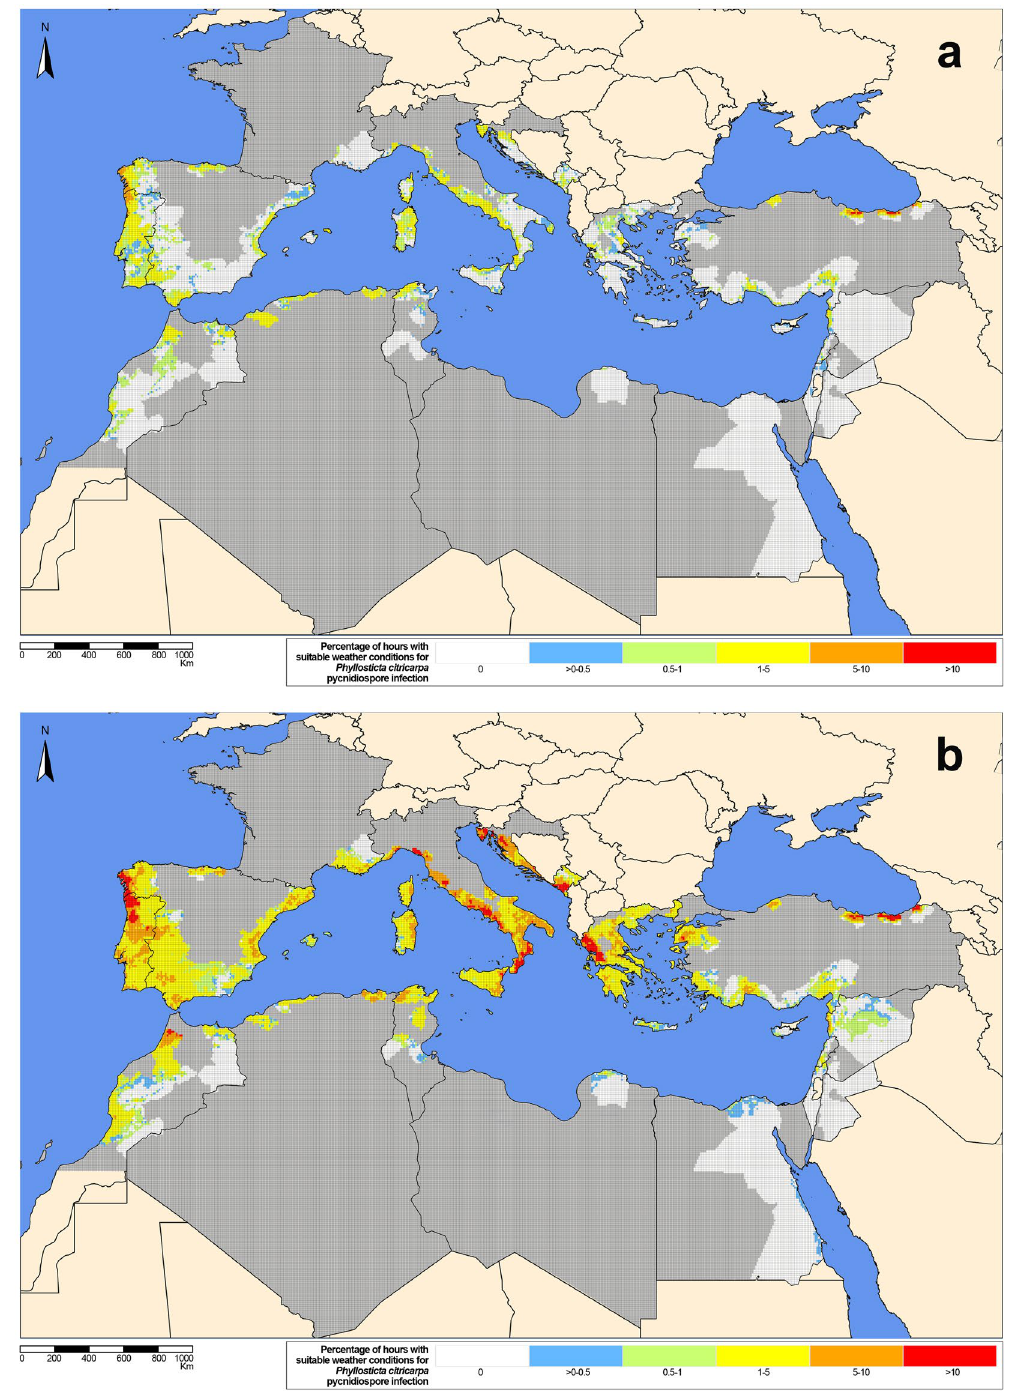
Figure 2. Percentage of hours ( = 0 white, ]0–0.5] blue, ]0.5–1] green, ]1–5] yellow, ]5–10] orange, > 10 red) with suitable weather conditions for Phyllosticta citricarpa pycnidiospore infection (generic infection model for foliar fungal pathogens by Magarey et al. 33 , configuration scenario S1) for the 9-km grid interpolated climatic data of the citrus-growing regions in the Mediterranean Basin from 2009 to 2018 for ( a ) spring (March to May) and ( b ) autumn (September to November). Non citrus areas inside citrus-growing countries in dark-grey. The maps were created by the authors using the software R 3.6.0, https:// www.R- proje ct.